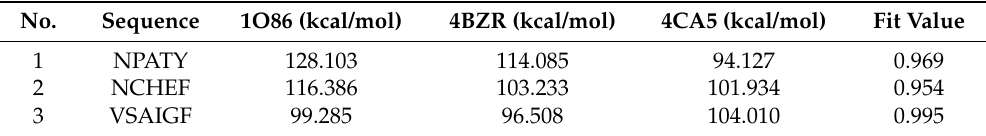
Table 5. The scores of potential adlay oligopeptides for ACE inhibitory activity.